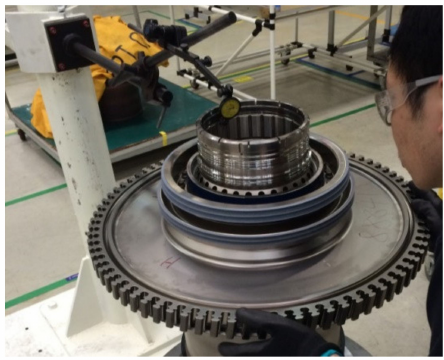
Figure 11. Adjustment and measurement of the